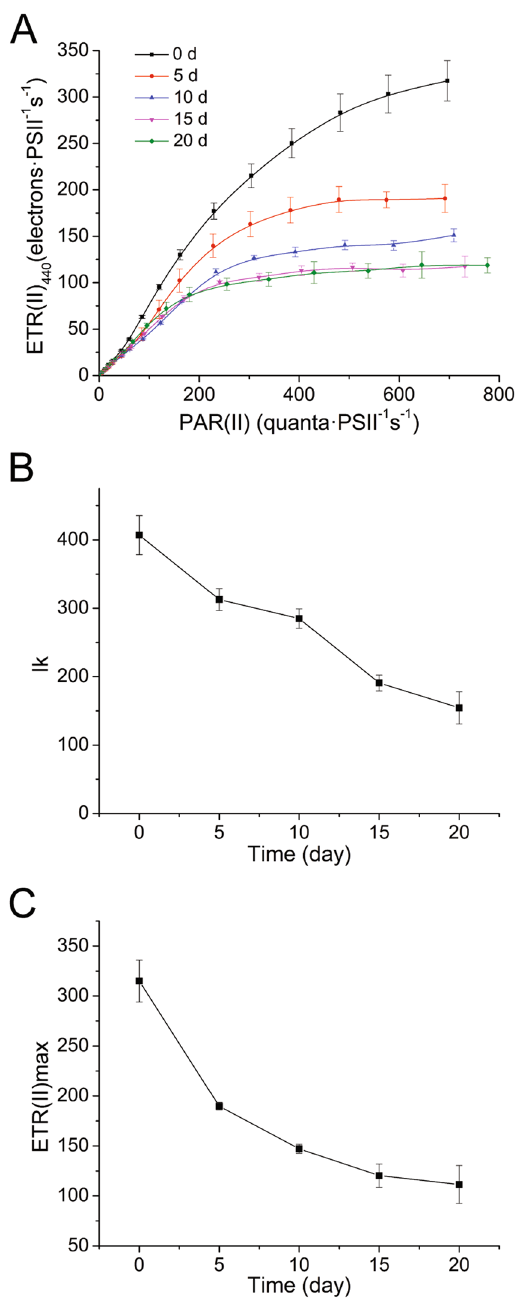
Figure 3. Variation in rapid light curves and fit parameters of nitrogen-starved P. cruentum . ( A ) ETR(II)-RLC of nitrogen-starved cells. ( B ) maximum electron transport rates ETR(II) max fitted by EP model equations. ( C ) semi-light saturation point I k fitted by EP model